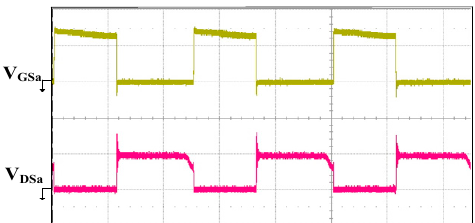
Figure 13. Experiment of voltage waveforms of S a (V GSa , V DSa ), V GSa , V DSa : 10 V/div, Time: 20 µs/div.